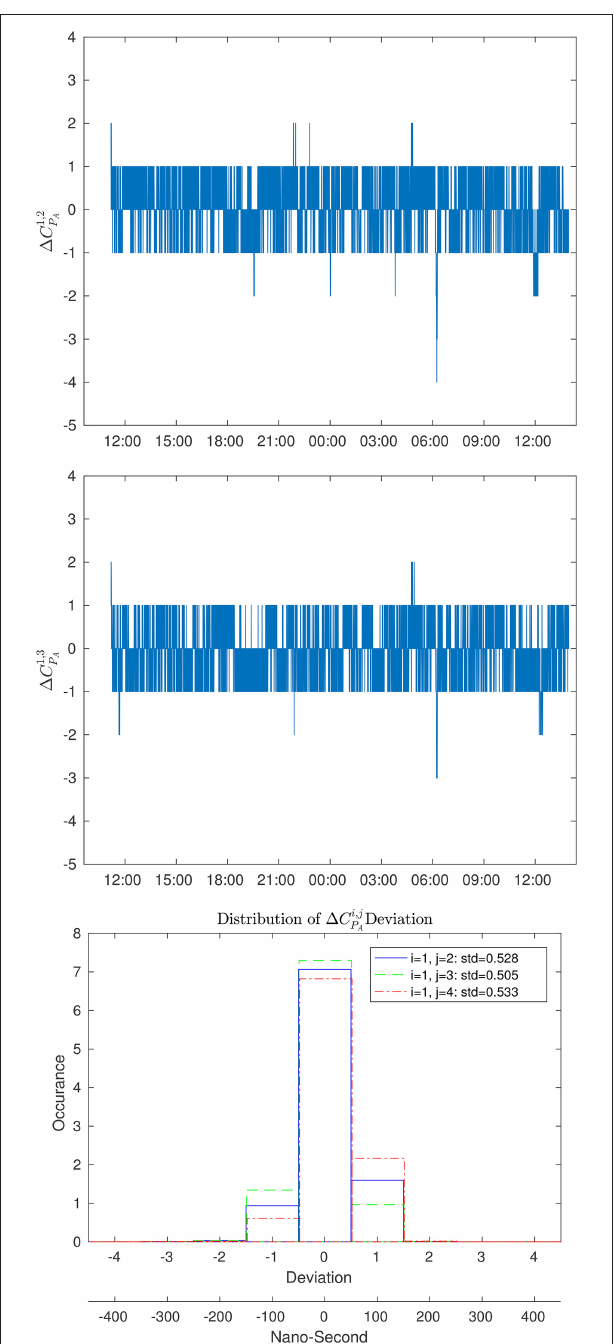
FIGURE 13 | Accuracy of PPS signals between two GPS modules: (top) 1 C 1,2 P , (middle) 1 C 1,3 P A j =